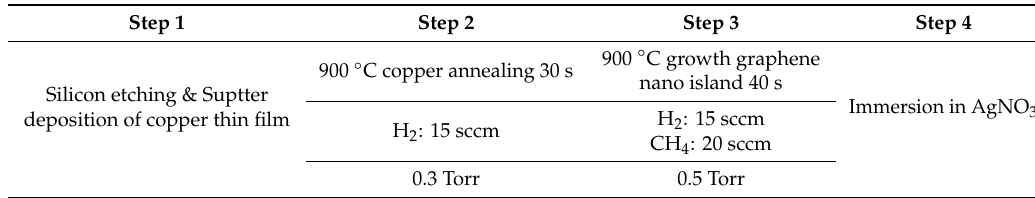
Table 2. Process Parameters for Copper Annealing and Graphene Rapid Thermal